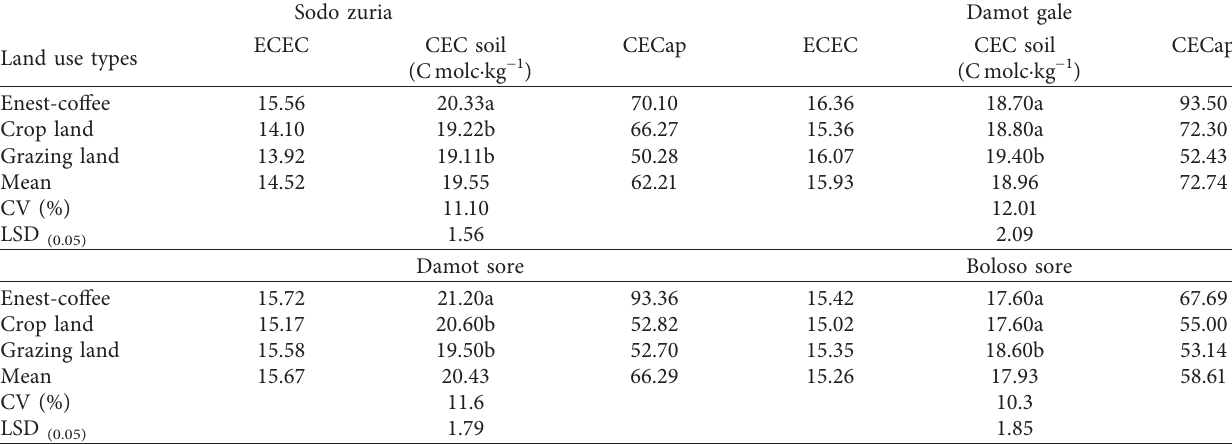
Table 6: Mean values ( n � 108) of cation exchangeable capacity in different locations and land use types.